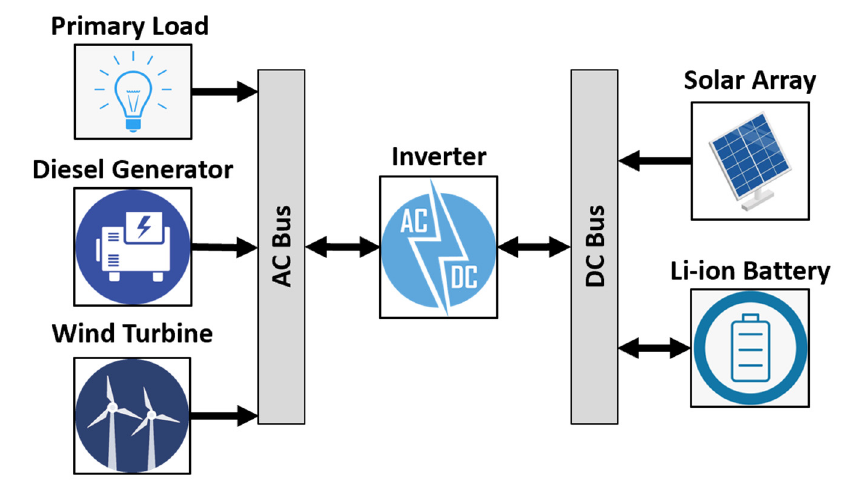
Figure 2. Architecture of a generic HES.